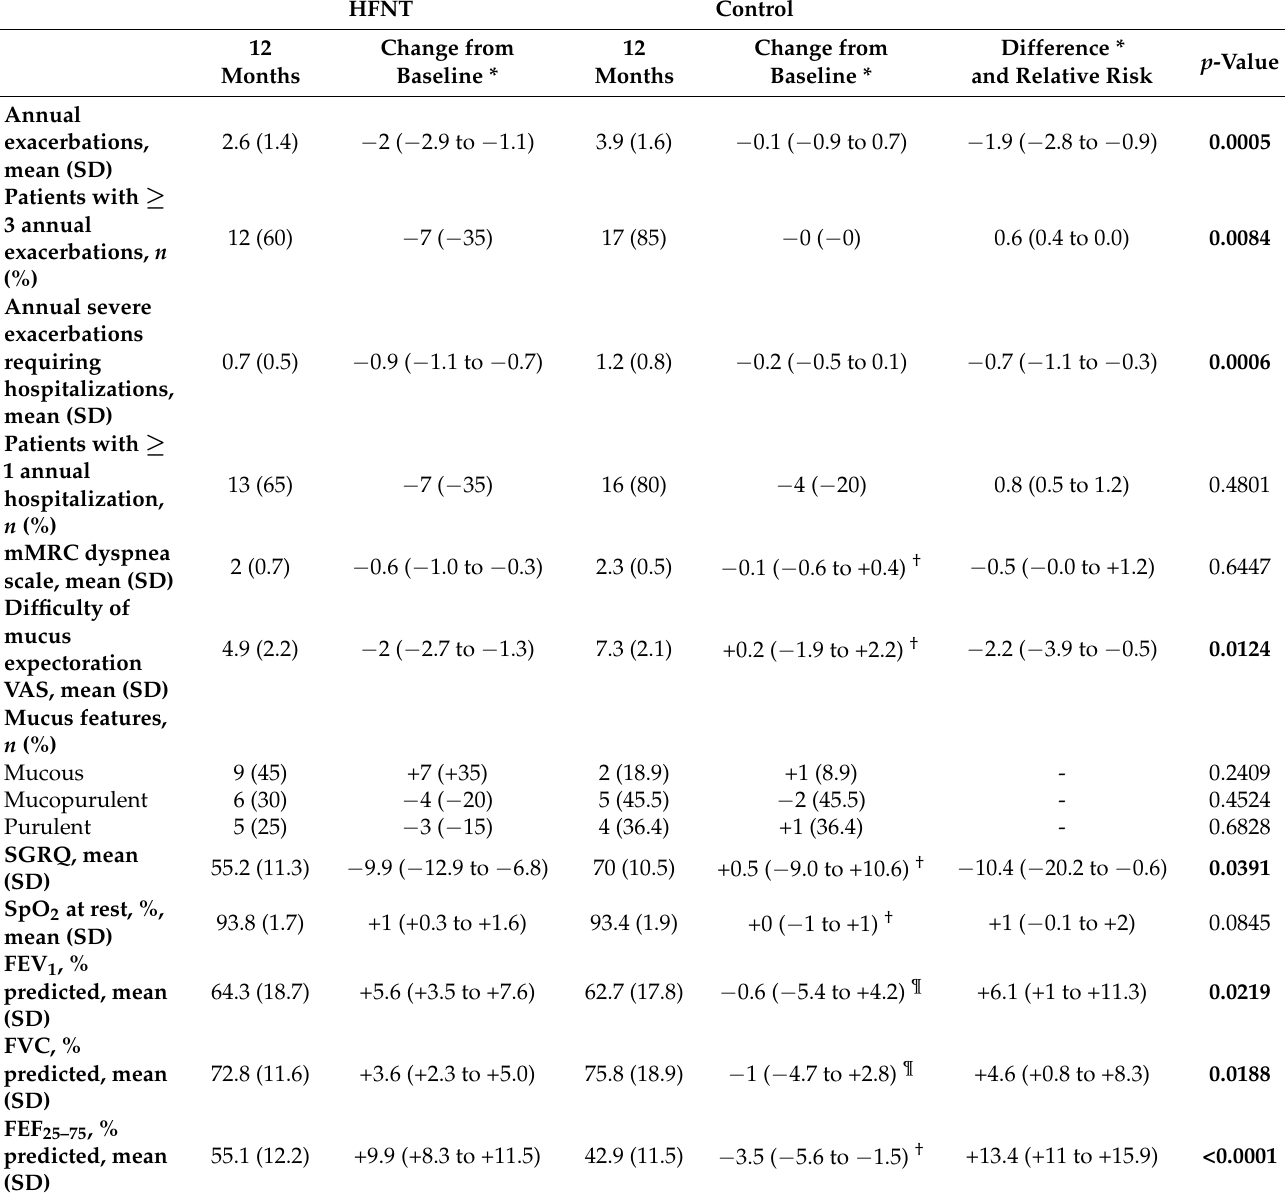
Table 3. Outcomes after 12